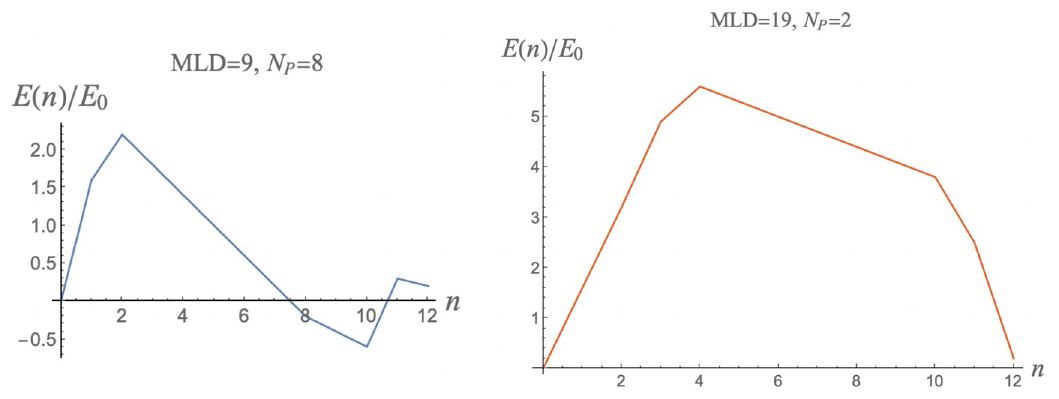
Fig 14. Minimum-energy assembly profiles for N P = 8, MLD = 9 spanning trees (left) and for N P = 2, MLD = 19 spanning trees (right) for − � 1 = −